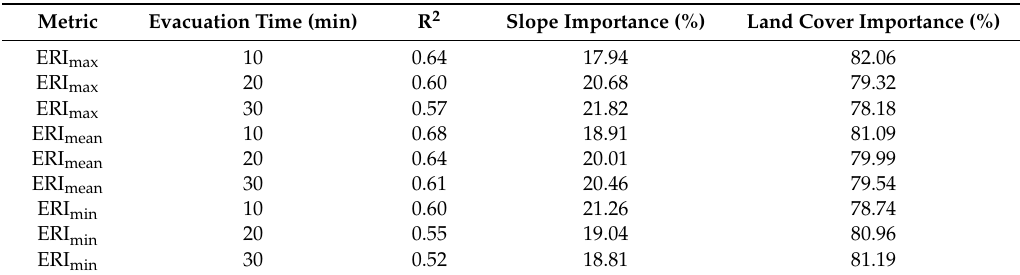
Figure 10. Large-scale maps containing the two model input datasets (a) elevation, roads/trails, and (b) land cover as well as model output datasets (c) ERI min , (d) ERI max , (e) ERI mean , and (f) ERI azimuth . Table 8. Descriptive statistics of ERI metric raster cell values for each of the time frames tested throughout the ANF.